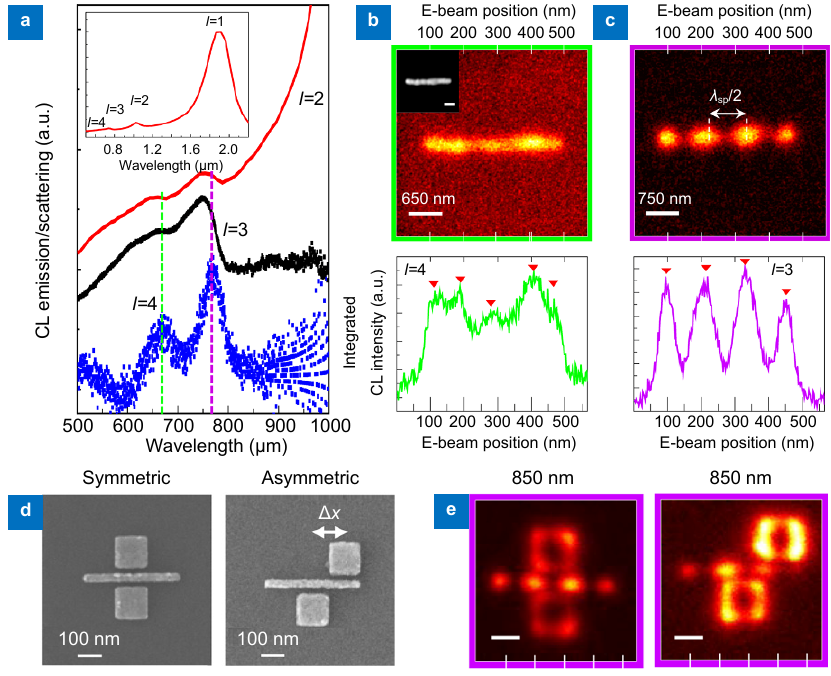
Fig. 7 | ( a ) FDTD (red) simulated, dark-field (black) scattering and CL emission spectrum of Au antenna indicate the standing wave eigenmodes. CL images of nanoantenna with bandpass filter at ( b ) 650 nm and ( c ) 750 nm. Integrated CL intensity shows the standing wave plasmon resonances. ( d ) SEM images of symmetric and asymmetric coupling structure of nanowire and nanoantennas. ( e ) CL images of two coupling structures with bandpass filter at 850 nm. Figure reproduced from ref. 42 , ACS